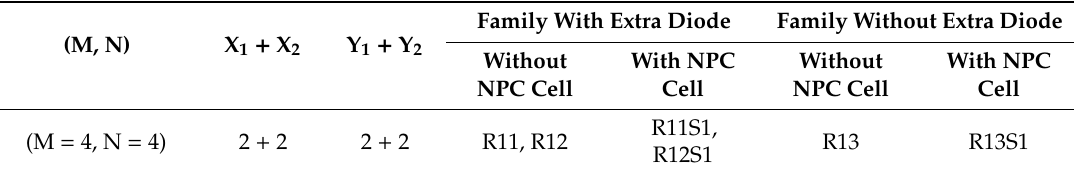
Table 3. Two NPC topology families under DFUSPWM.